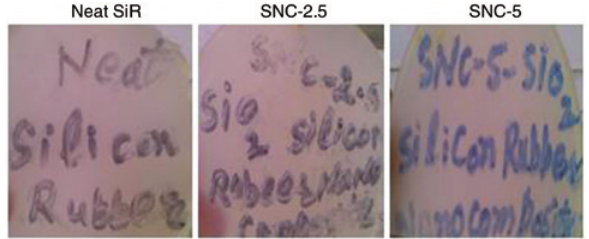
Figure 3: Photographs of 5000 h aged samples of neat SiR, SNC-2.5, and SNC-5.